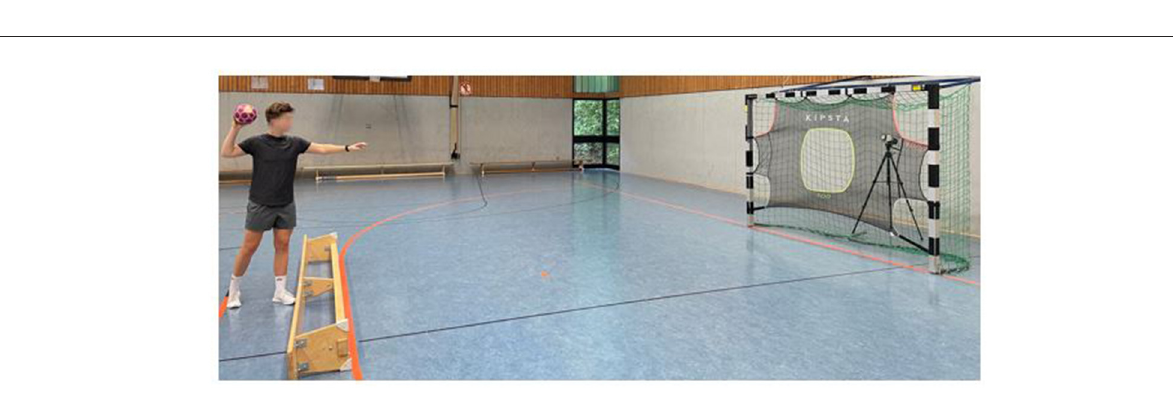
FIGURE3 Participant performing the 7-m standing throw